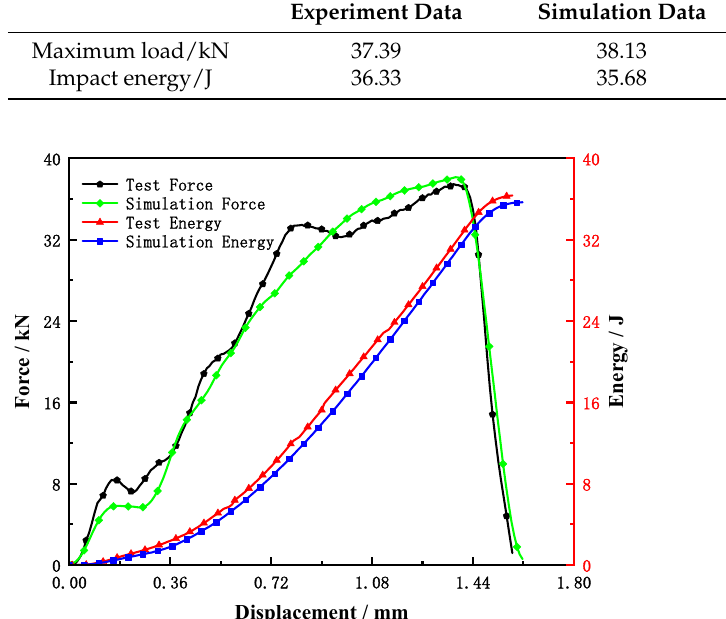
Figure 12. Comparison of force vs. displacement and energy vs. displacement between simulated and experimental Charpy impact tests.